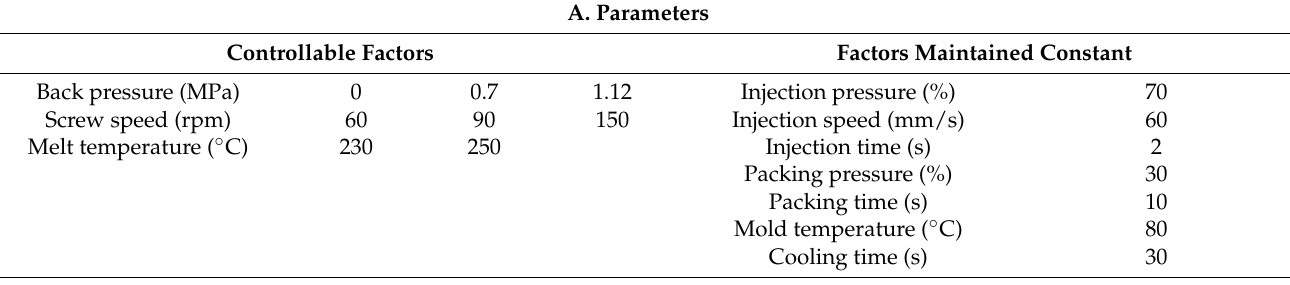
Table 1. Configuration of the injection-molded long-glass-fiber-reinforced polypropylene composites.